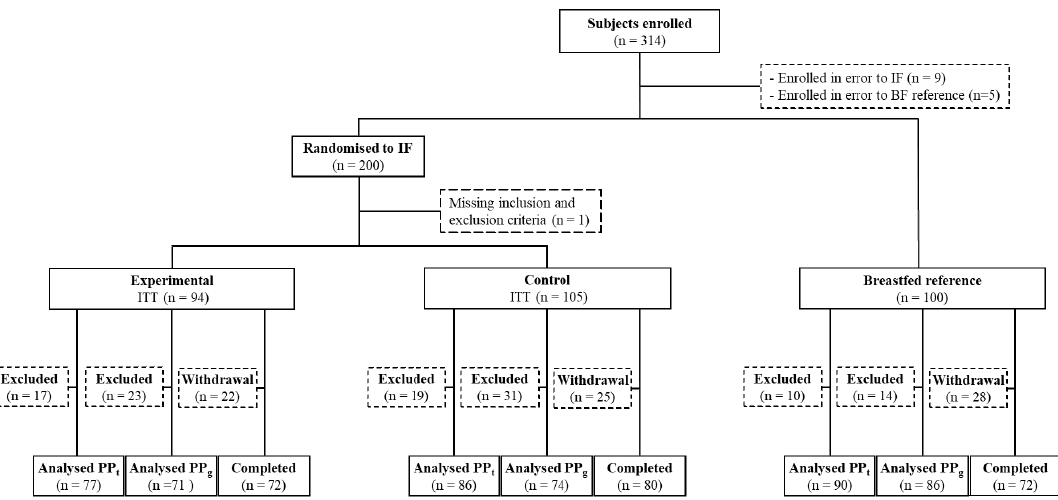
Figure 1. Flow diagram of participants through study, from enrolment to study completion, for Intention to Treat (ITT) and Per Protocol tolerance (PP t ) and Per Protocol growth (PP g ) populations. Protocol compliance was based on visit level, explaining the higher number in the PP vs. the Completers population within all three study groups. IF = infant formula; BF = breastfed. Table 1. Demographics and baseline characteristics of infants per intervention group of the intention to treat population *.